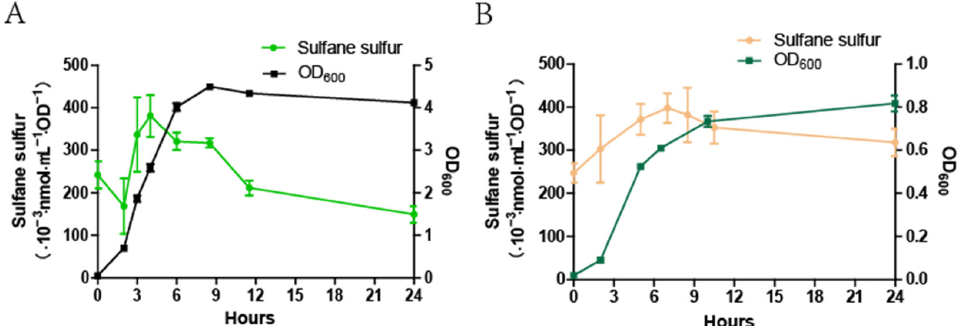
Figure 6. The iSS content of E. coli cells cultured under aerobic and anaerobic conditions. The E. coli BL21(DE3) cells were incubated in an LB medium and cultured under aerobic ( A ) and anaerobic conditions ( B ). The OD 600 and iSS content was detected at defined time intervals. Three parallel experiments for each condition were performed to obtain the averages and standard deviations (n = 3).